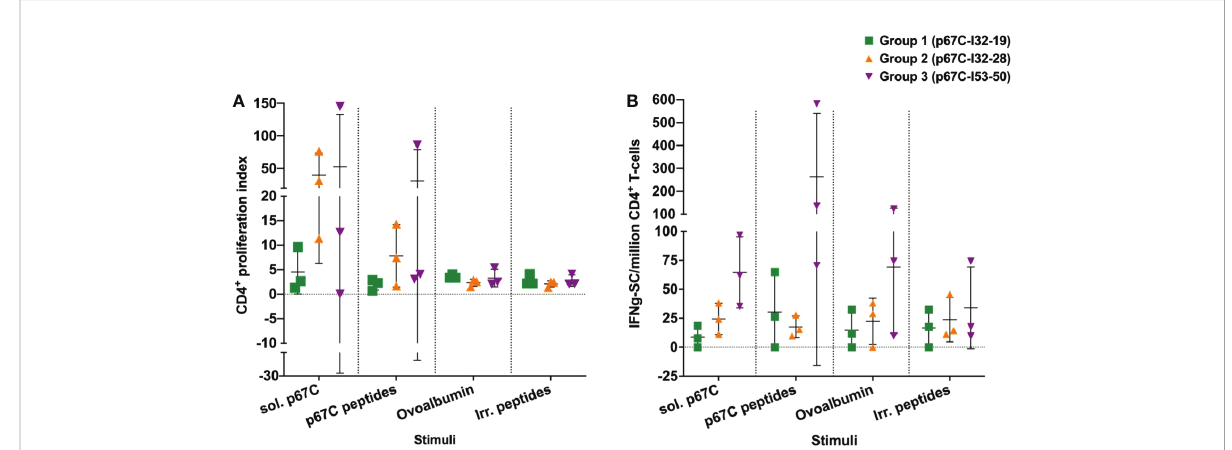
FIGURE 4 The responses of enriched CD4 + T-cell from immunized cattle to different stimuli were measured in cattle from immunogenicity studies. (A) The p67C-speci fi c proliferative cellular response; and (B) the p67C-speci fi c IFN g -secreting cells per million of CD4 + T-cells in individual animals from group 1 to 3. Two different stimuli were used: soluble protein (sol. p67C) and a pool of 25-mer p67C overlapping peptides (p67C peptides). Negative stimulus responses are also included: ovalbumin and irrelevant peptides (irr. peptides). In both panels individual animals (n=3), the mean and standard error of the mean bars are